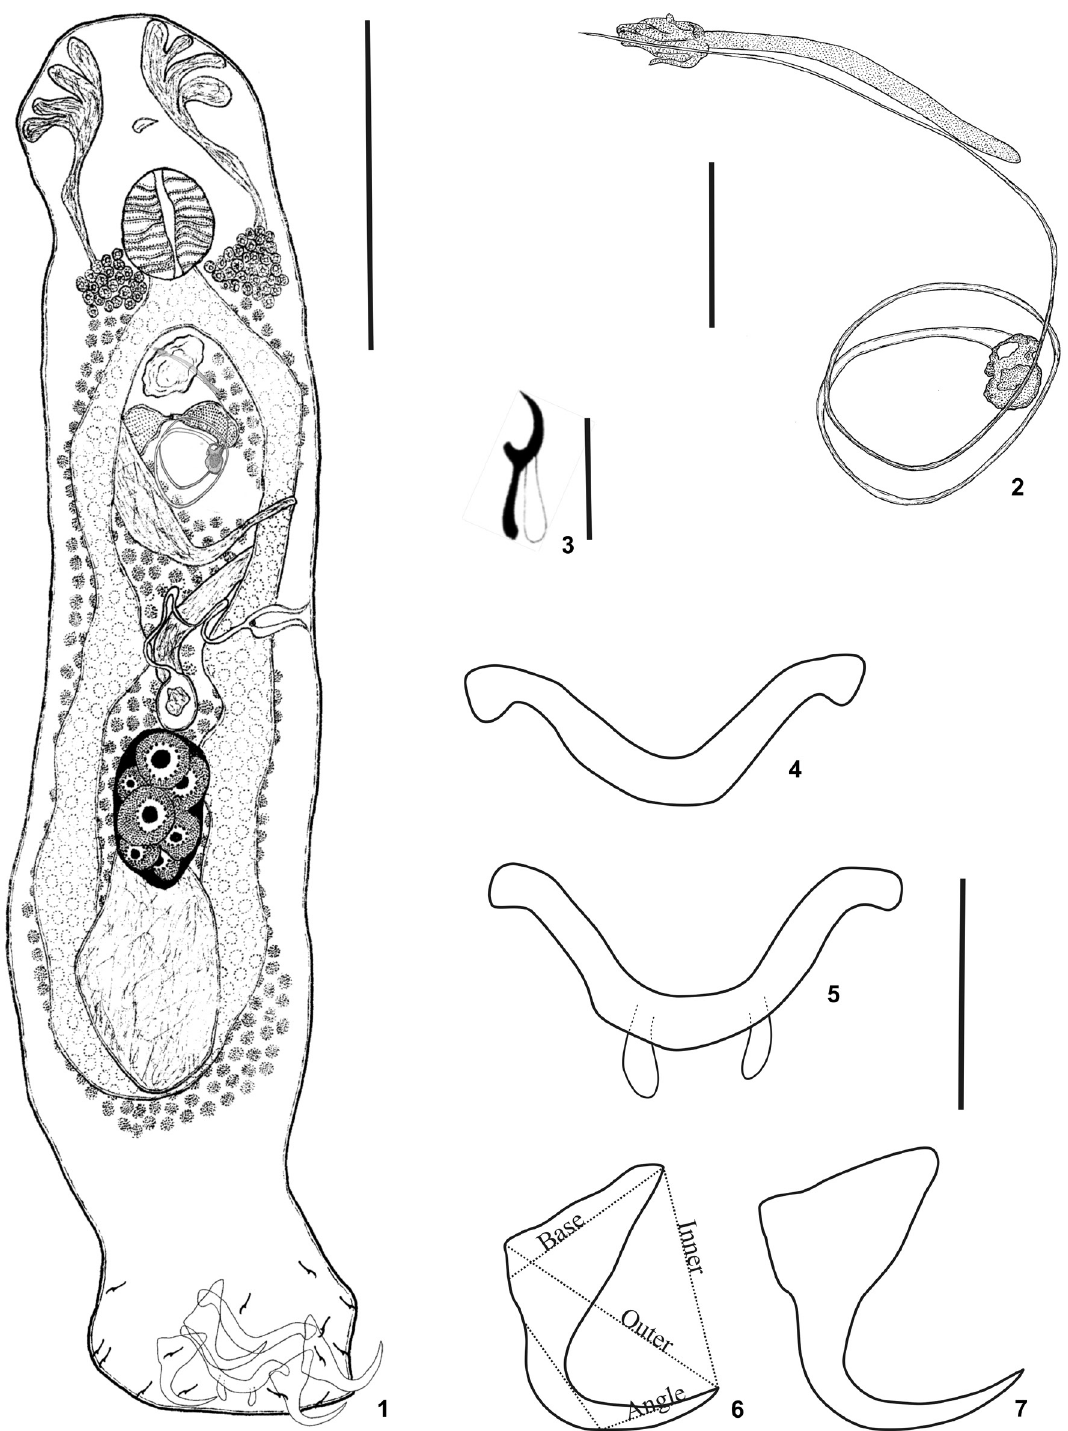
Figures 1–7. Cosmetocleithrum phryctophallus sp. nov.: (1) holotype whole-mount, ventral; (2) copulatory complex; (3) hook; (4) ventral bar; (5) dorsal bar; (6) ventral anchor; (7) dorsal anchor. Scale bars: 1 = 100 μm; 2, 4–7 = 25 μm; 3 = 10